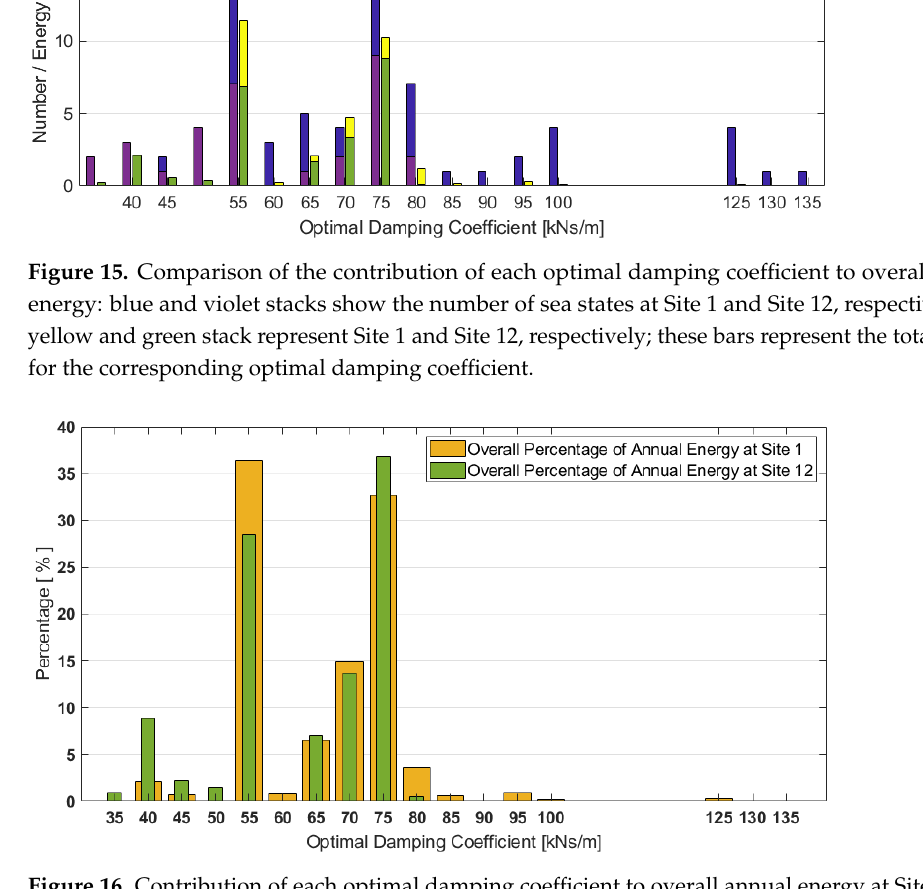
Figure 16. Contribution of each optimal damping coefficient to overall annual energy at Site 12. The orange stack and green stack represent the percentage for the energy of the corresponding coefficient toward the overall annual energy production, respectively.